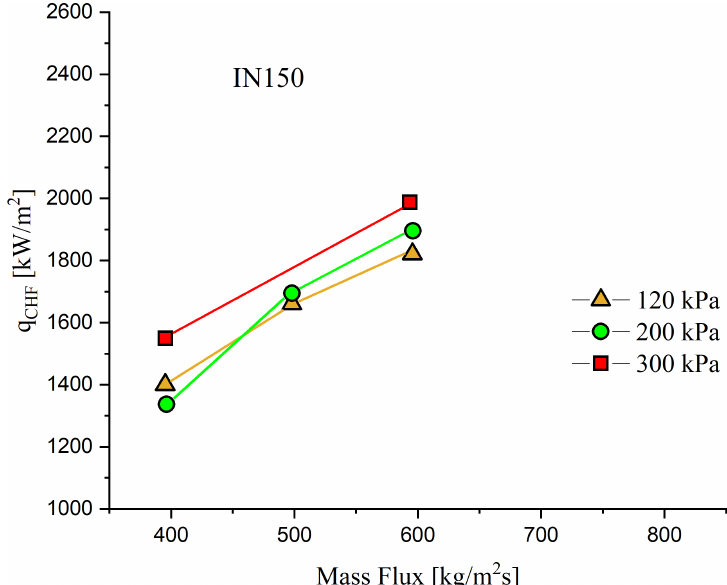
Figure 13. CHF measurements as a function of mass flux at different outlet pressures and inlet subcooling on abraded Inconel